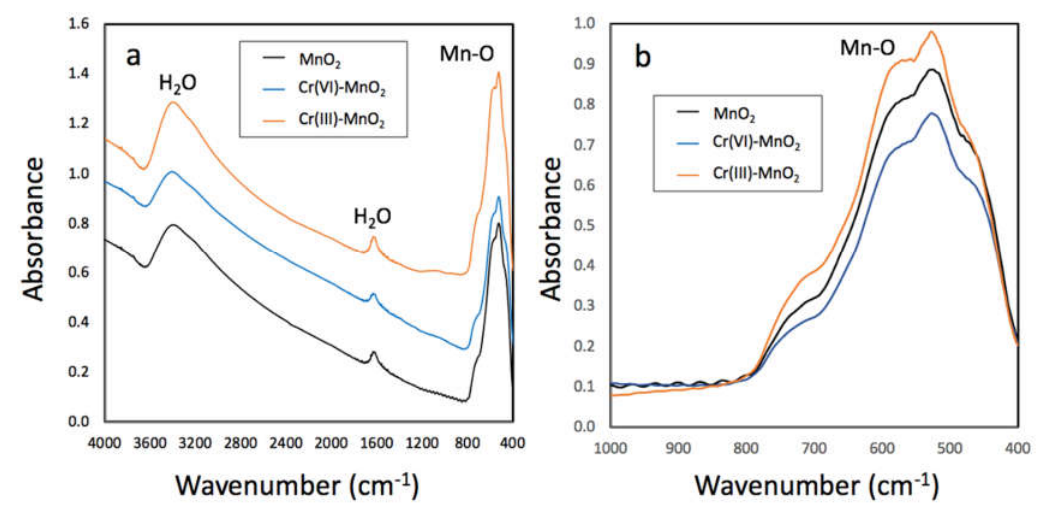
Figure 12. FTIR absorbance spectra of unreacted MnO 2 , Cr(VI)-treated MnO 2 , and Cr(III)-treated MnO 2 showing ( a ) the entire 400–4000 cm −1 spectral range and ( b ) a magnified view of the Mn–O peak region (400–1000 cm −1 ) showing the effects of Cr(III) and Cr(VI) treatment. The data in ( b ) were baseline-corrected and normalized to the spectral region at 800 cm −1 .